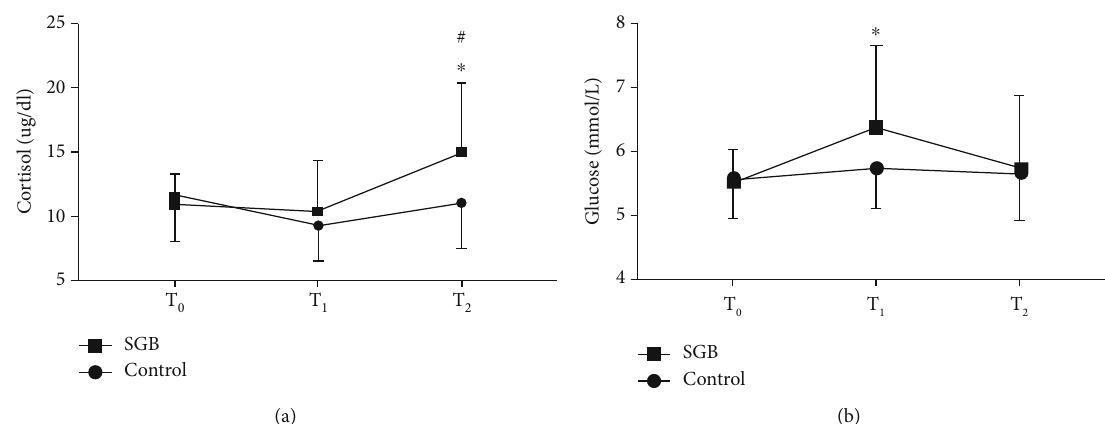
Figure 2: Plasma concentration of cortisol (a) and glucose (b). SGB: stellate ganglion block; T0: baseline; T1: immediately after incision; T2: at the end of surgery. Data are expressed as mean ± SD . ∗ P < 0 : 05 compared with the PNB only group; # P < 0 : 05 compared with baseline.